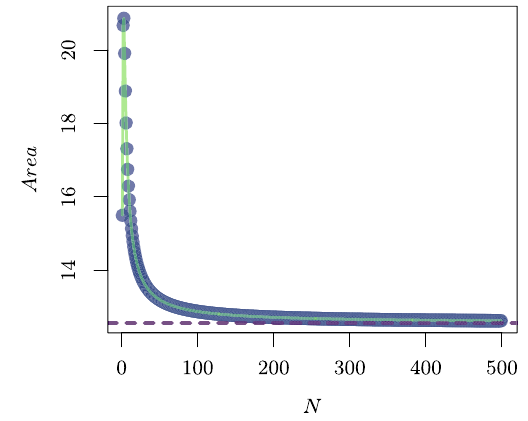
Fig. 8 The area is followed as a function of N for the ignorable coor- dinate case for a =